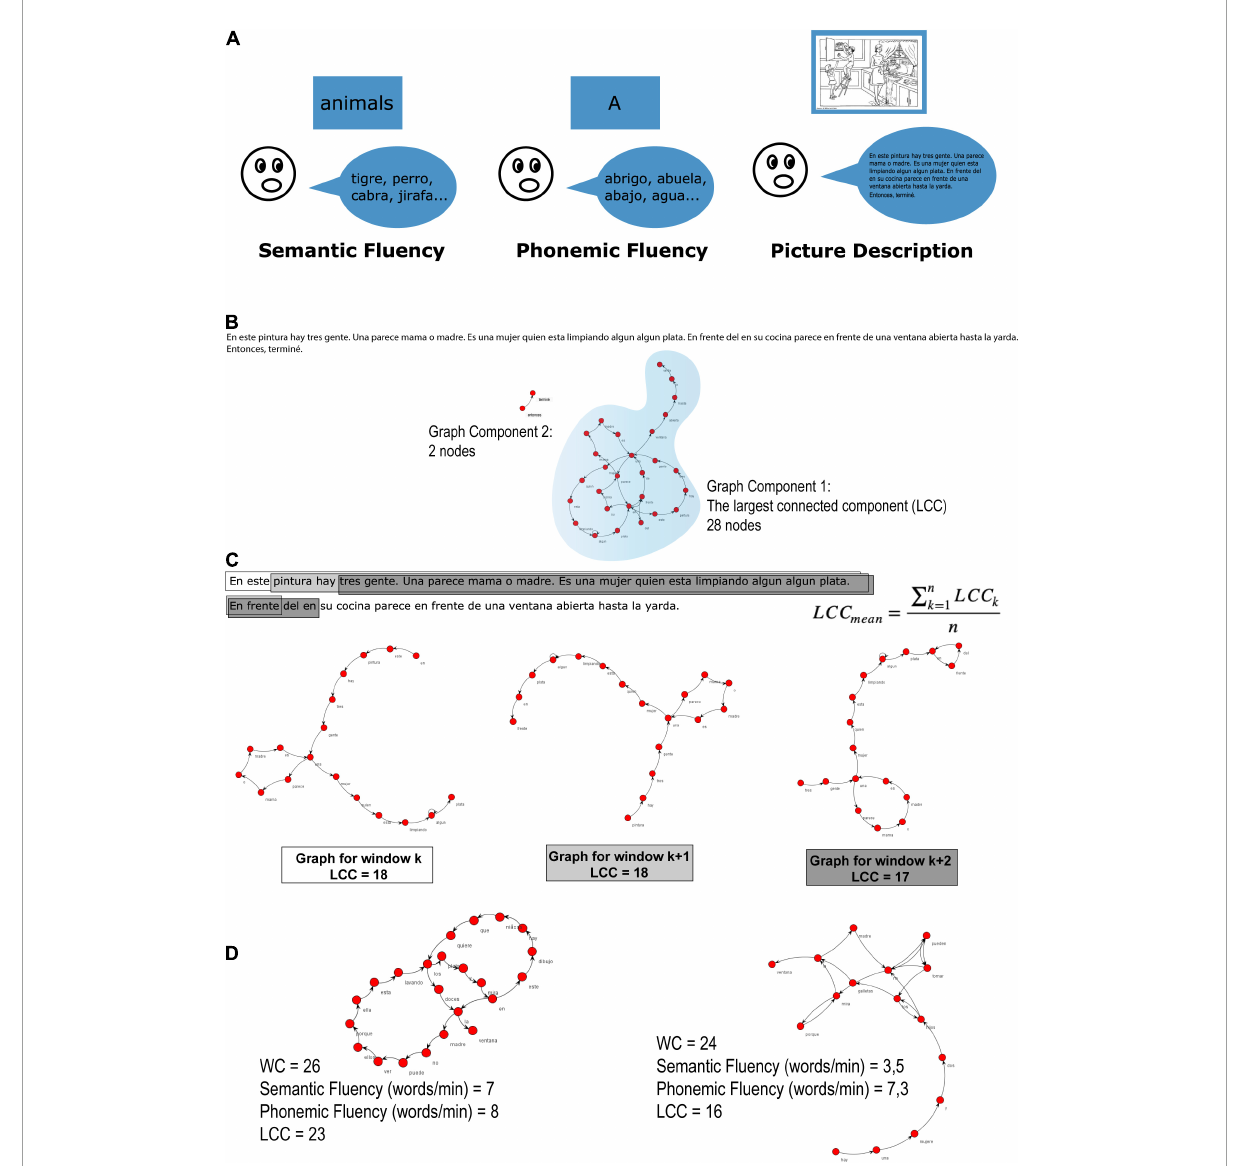
FIGURE1 Verbal fluency tasks and graph analysis procedures. (A) Semantic fluency, phonemic fluency and picture description were operationalized as the number of words per minute. (B) An illustrative example of a graph from a text considering interruptions (here, when there is an interruption from the oral narrative, the following text after the interruption is transcribed in another line). If there are no repeated words, there will be two different components. The LCC counts the number of nodes inside the largest connected component (LCC, indicated by the blue shade). (C) To control for verbosity, narratives were analyzed using a moving window of a fixed word length (20 words) with a step of two words. LCC is averaged over the text windows. An example of a text divided into windows of 20 words, jumping two words to the following window.